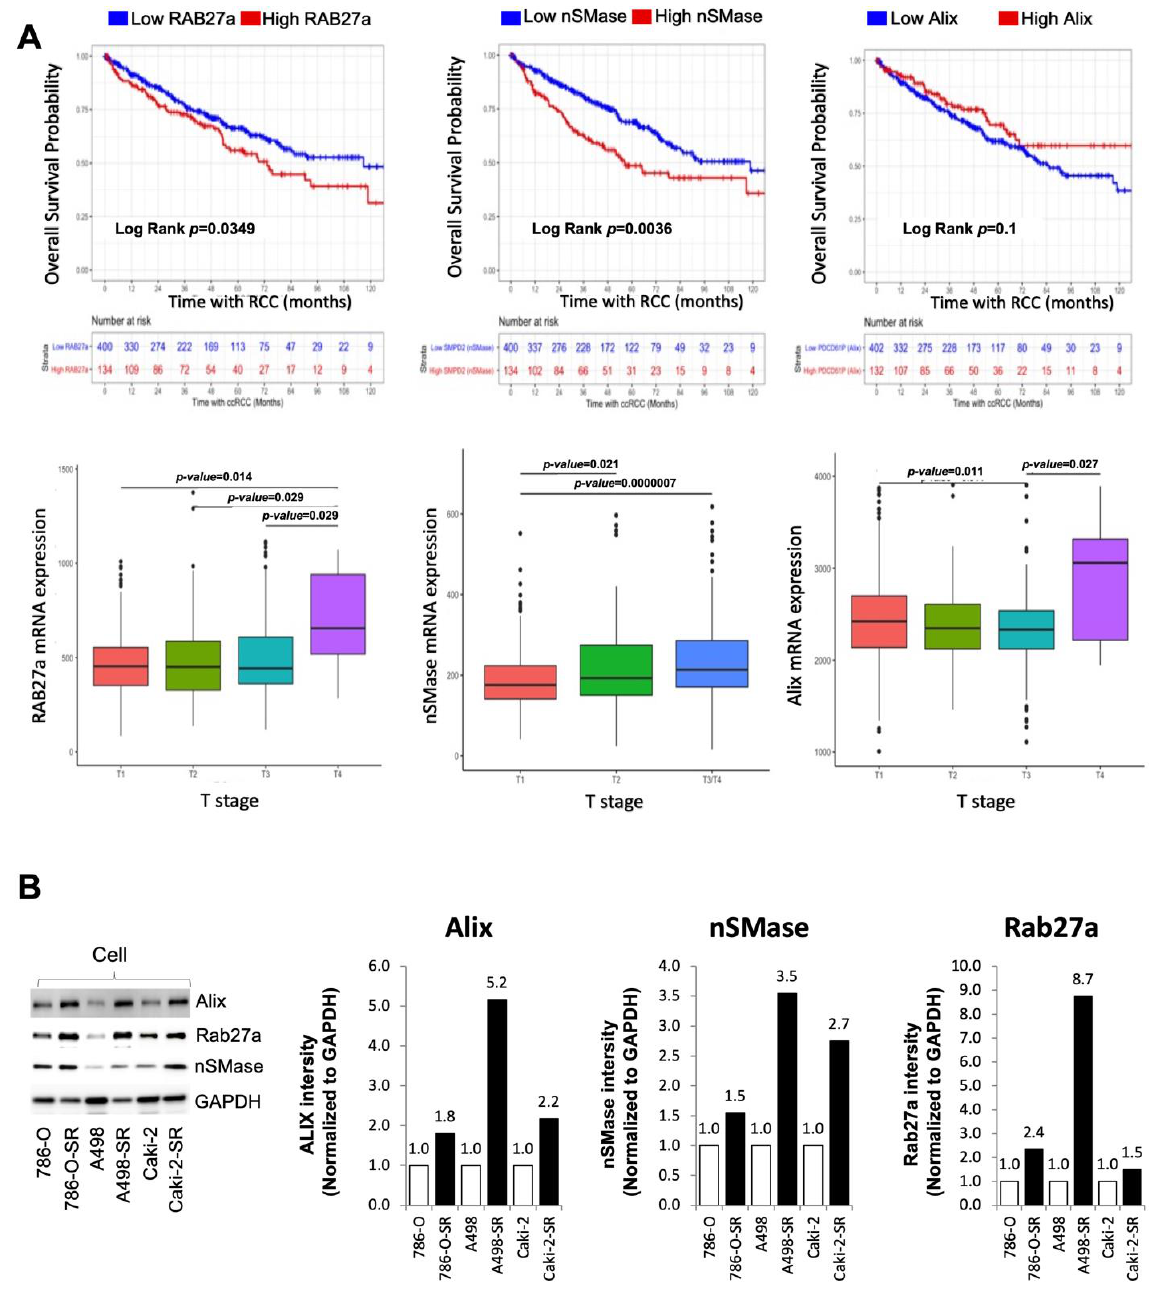
Figure 3. Clinical significance of Alix, nSMase, and RAB27a expression in RCC or SS and SR RCC cell lines. ( A ) Kaplan–Meier curve generated by implementing data from the TCGA database revealed that the high RAB27a expression group had significantly lower overall survival (OS) when compared to the outcomes of patients with low RAB27a mRNA expression. When comparing RAB27a mRNA expression between pathologic T stage, T4 displayed higher levels then all others. ( B ) Alix, nSMase, or RAB27a protein expression within each cell line were determined by western blotting. In all of the SR RCC cell lines, protein expression of Alix, nSMase, or RAB27a were higher when compared to each SS parent cell line. GAPDH was used as a loading control and full blots are presented in Supplementary Figure S8.